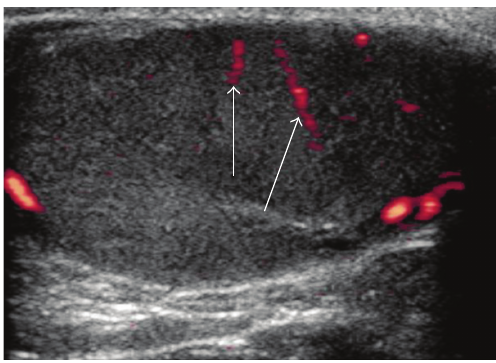
Figure 7: Ultrasonogram of a testis using color pulsed-wave Dop- pler ultrasonography showing blood flow within the recurrent rami